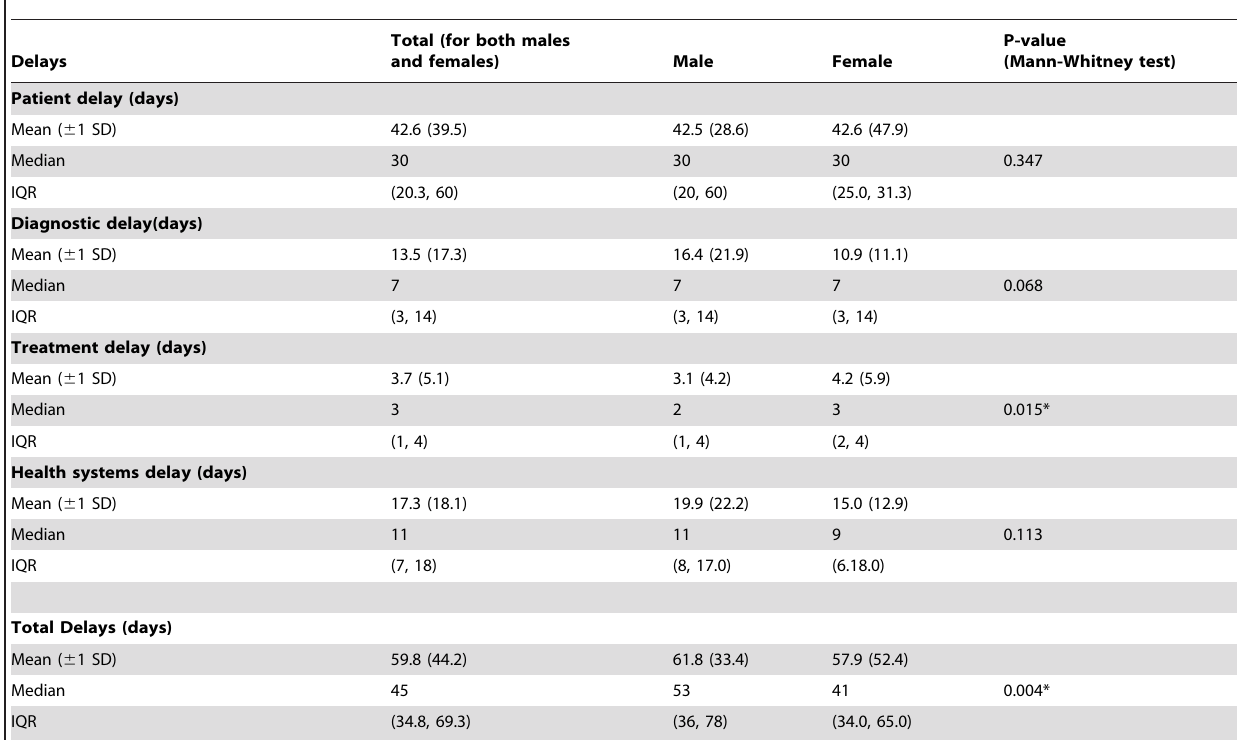
Table 3. Different categories of total delay segregated by sex of study participants, southern Ethiopia, June-December 2012.